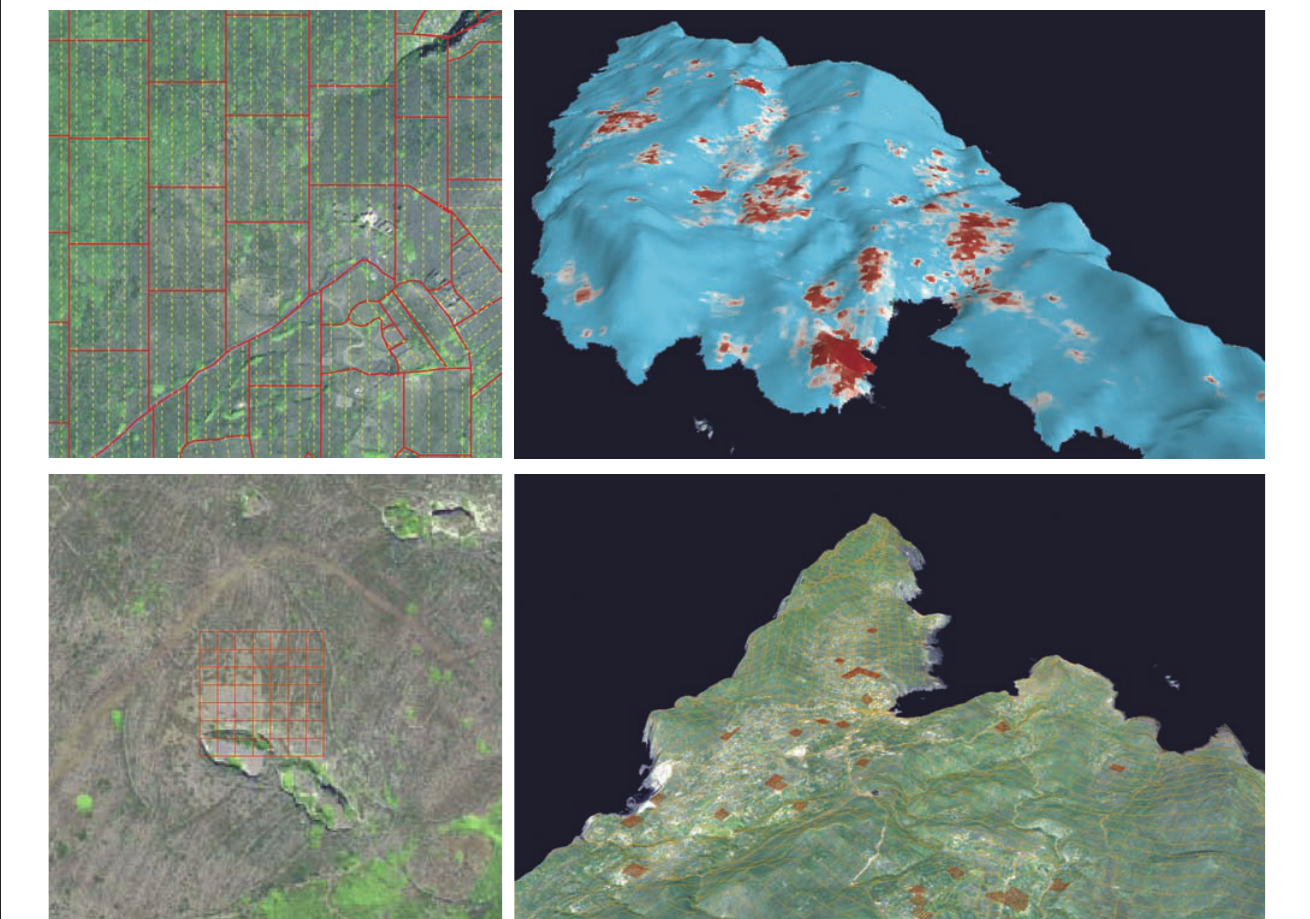
Figure 3 ASP’s surface survey methods: a) stage-one “tractwalking” by surveyors spaced 15m apart, b) a perspective view looking south, with the density of surface pottery (all periods) plotted from the records of each individual walker, c) stage-two collection in 10x10m squares, d) a perspective view looking north, with the stage-one tract units outlines in orange and the stage-two gridded collections shown in